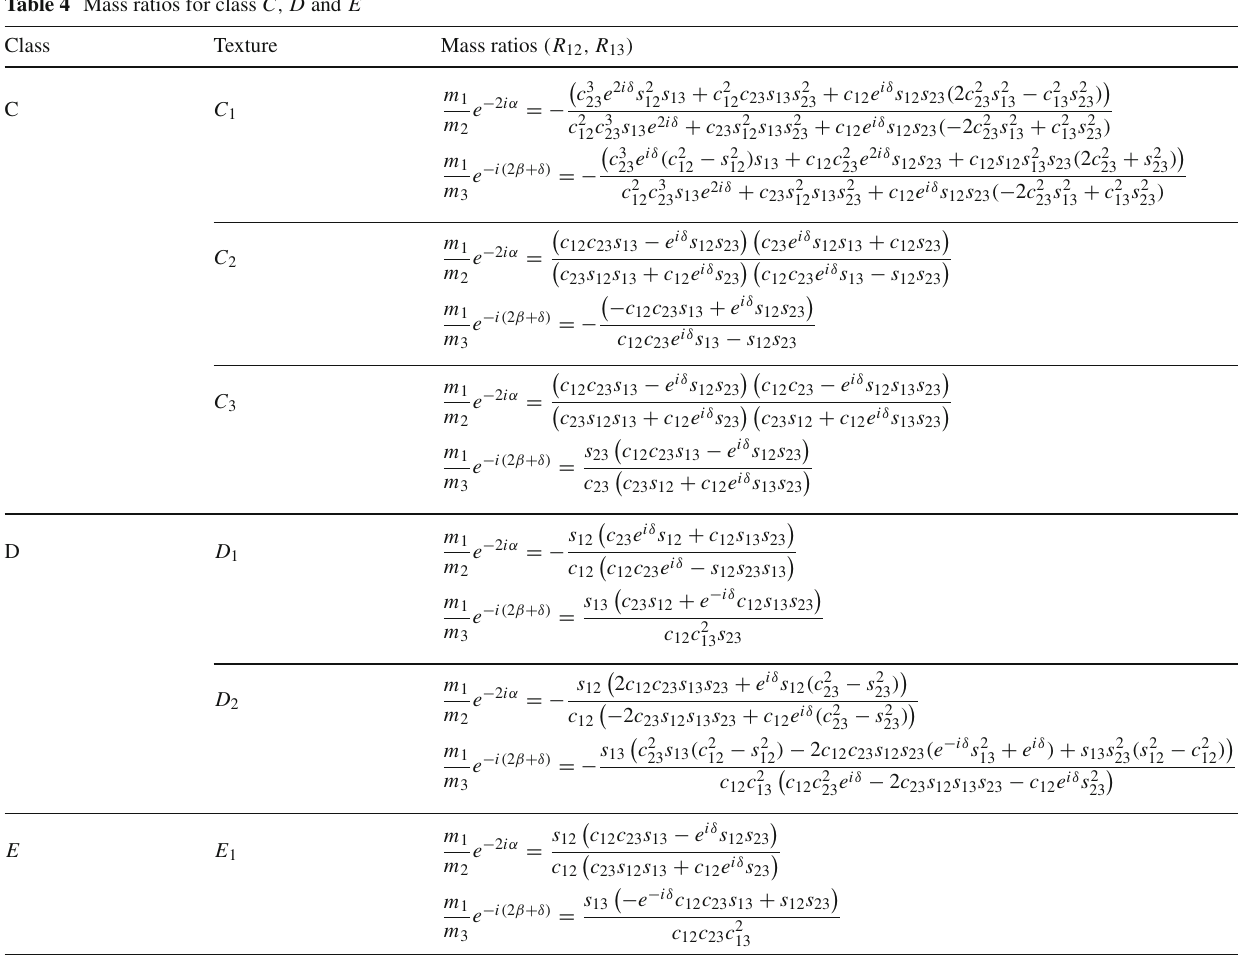
Table 4 Mass ratios for class C , D and